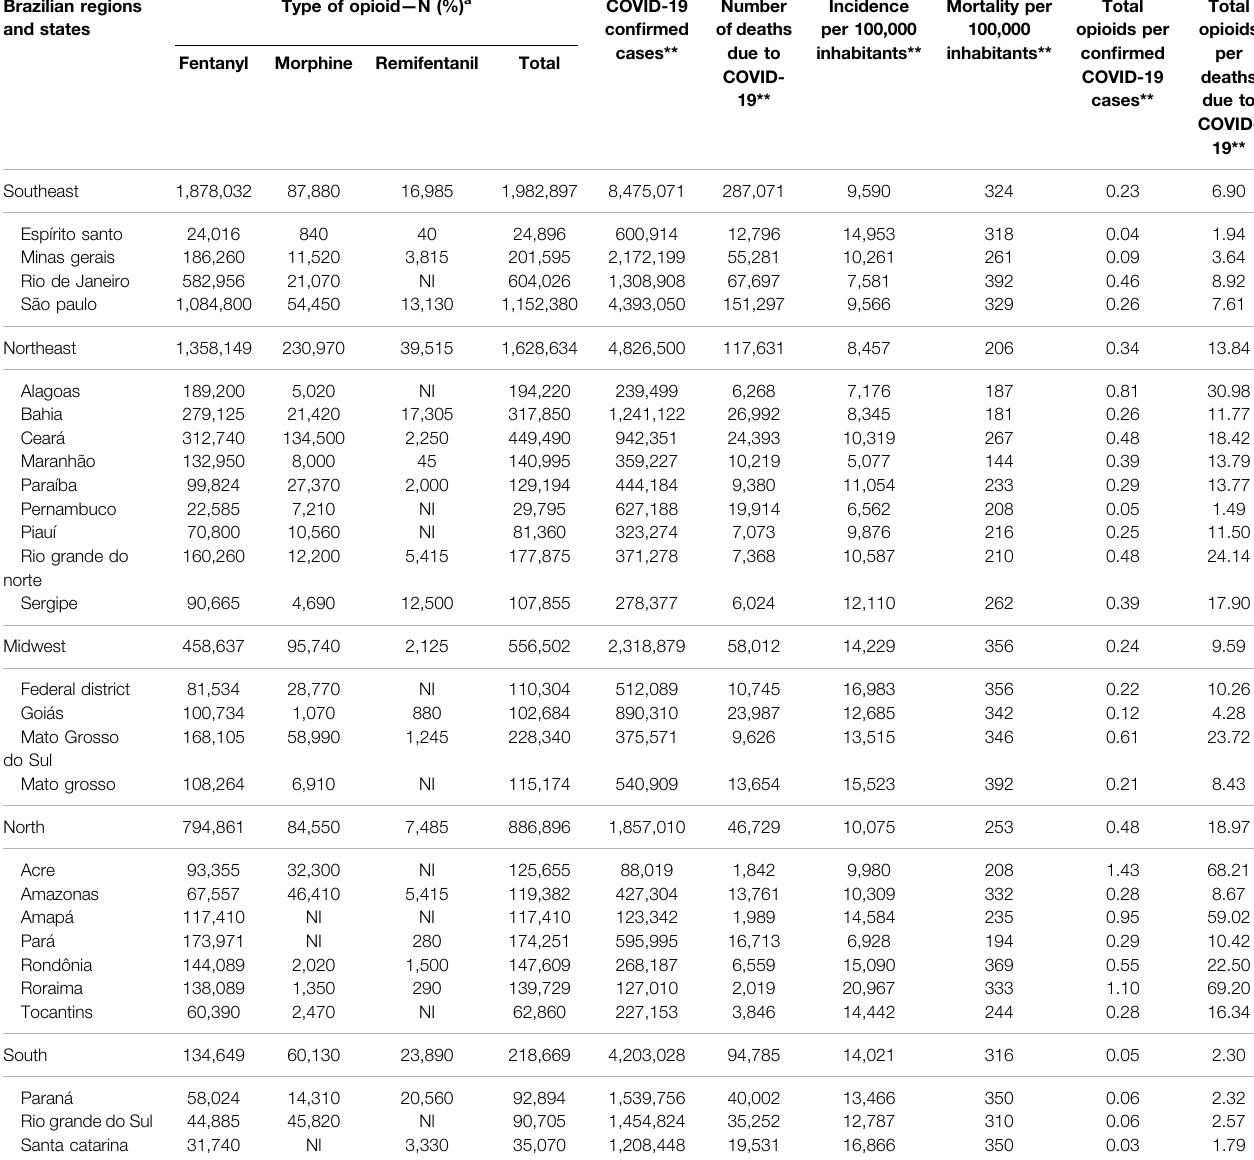
TABLE 2 | Epidemiological characteristics of coronavirus disease (COVID)-19 cases, death, and distribution of opioids in the Brazilian states and Federal District. Brazilian regions and